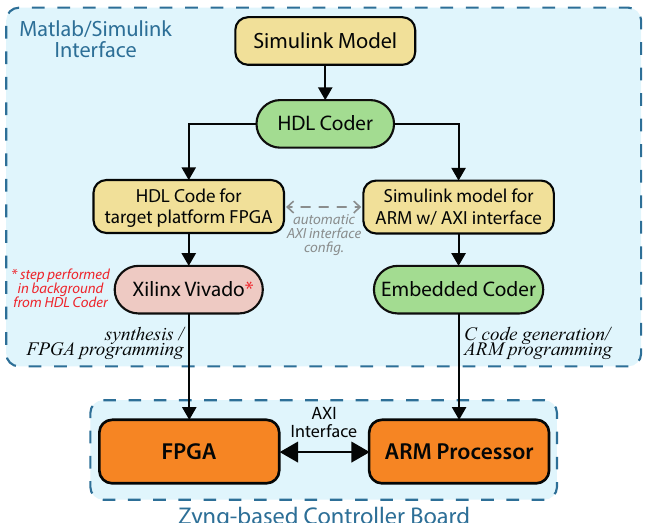
Figure 5. Schematic representation of the Zynq programming workflow from